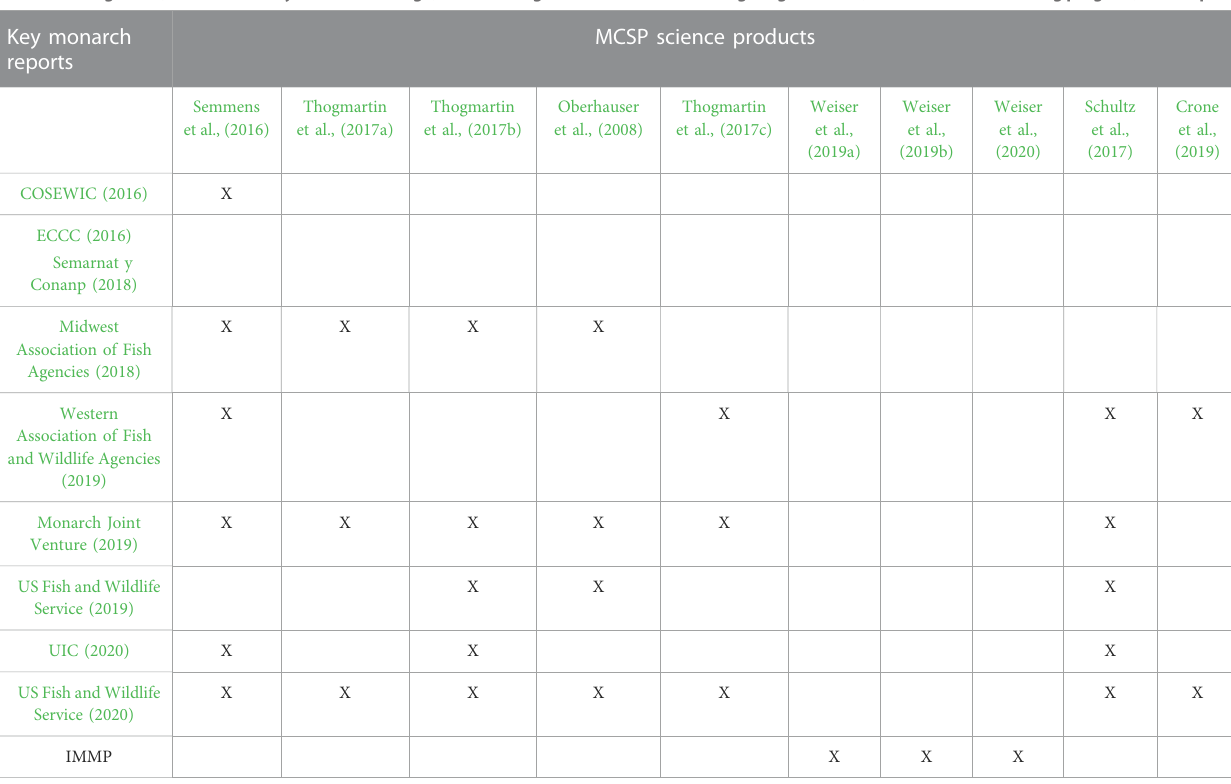
TABLE 1 Key management reports, conservation plans, or monitoring programs (rows) and the MCSP science products they referenced (Columns). All items are listed as they are cited and can be found in the literature cited. COSEWIC = Committee on 222 the Status of Endangered Wildlife in Canada, ECCC = Environment and Climate Change Canada, MAFWA = Midwest Association of Fish and Wildlife Agencies, MJV = Monarch Joint Venture, WAFWA = Western Association of Fish